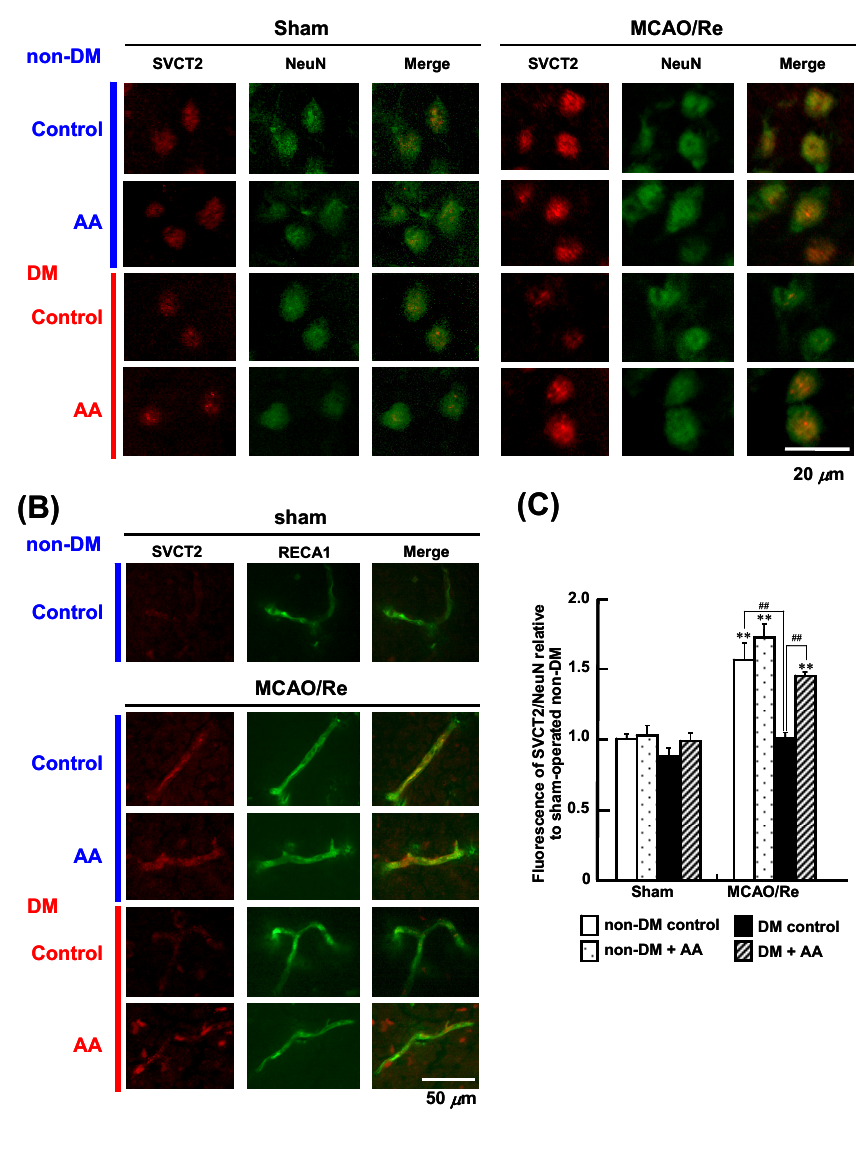
Figure 9. Effects of AA supplementation on SVCT2 and GLUT1 expression in the ischemic penumbral cortex of nondiabetic and diabetic rats. Expression levels of SVCT2 ( A – C ) and GLUT1 ( D , E ) were assessed using immunohistostaining of the penumbral cortex of nondiabetic and diabetic rats after MCAO/Re. Immunohistochemical expression of SVCT2 (red fluorescence) merged with NeuN ( A ) or with RECA1 ( B ) (green fluorescence); ( C ) Quantitative analysis of SVCT2 fluorescence intensity in the cortex. # p < 0.05, ## p < 0.01. * p < 0.05, ** p < 0.01 compared with the respective sham-operated nondiabetic controls; ( D ) Immunohistochemical expression of GLUT1 (red fluorescence) merged with RECA1 (green fluorescence); ( E ) Quantitative analysis of SVCT2 fluorescence intensity in the cortex. * p < 0.05, ** p < 0.01 compared with the respective sham-operated nondiabetic controls. † p < 0.05, †† p < 0.01 compared with the respective sham-operated diabetic